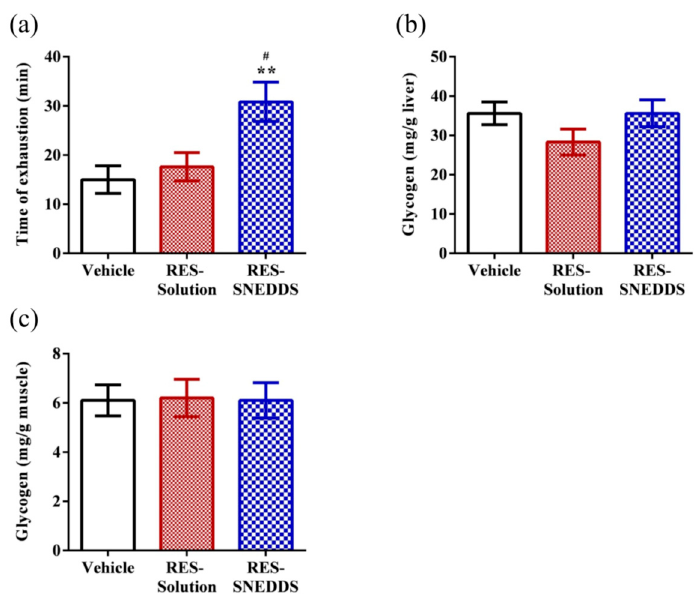
Figure 7. Effect of resveratrol (RES) on: ( a ) exhaustive swimming test; and glycogen content in: ( b ) liver; and ( c ) muscle. Data are expressed as mean ± standard error of the mean ( n = 5 for each group). ** p < 0.01 compared with vehicle group. # p < 0.05 compared with RES-solution group.